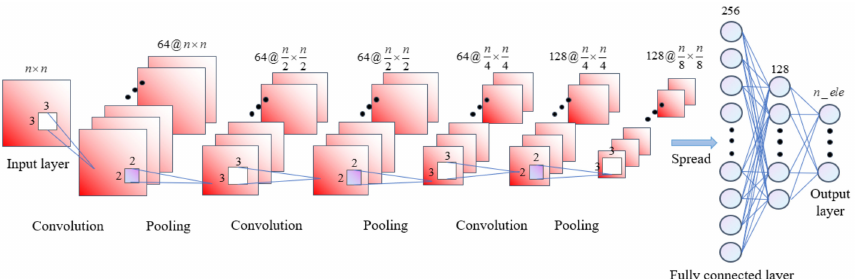
Figure 1. The proposed CNN for SDL ( n : the number of acceleration sensors; n_ele : the number of